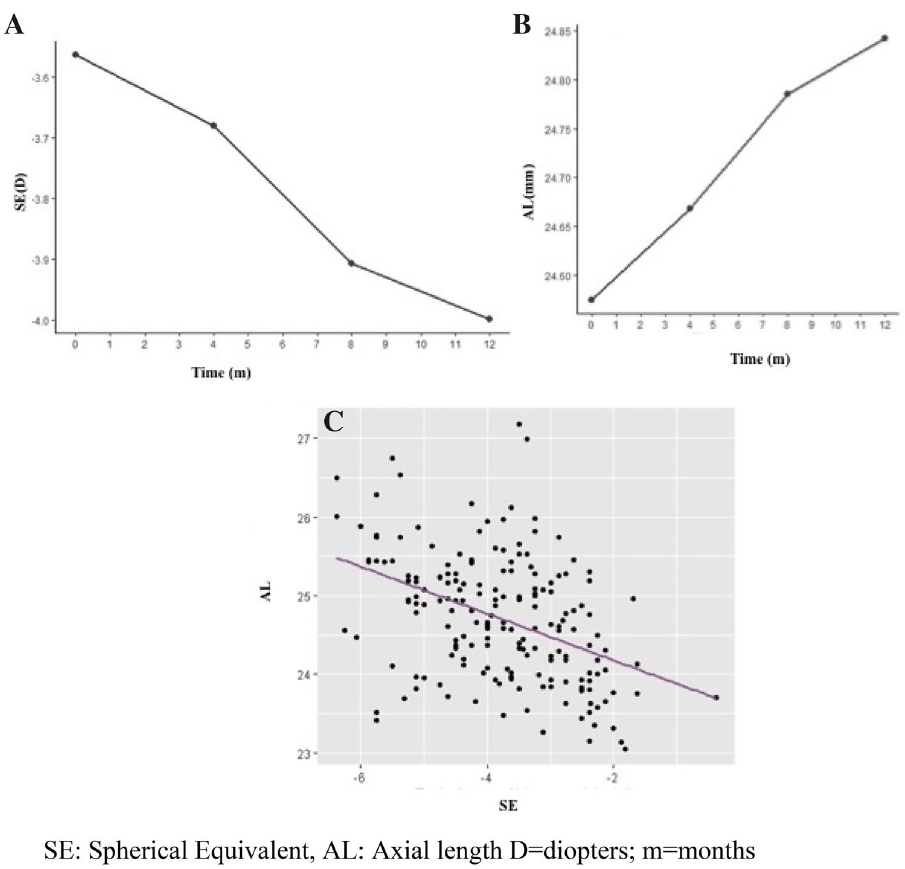
Figure 1. A Change in spherical equivalent across the time. B Change in axial length across the time. C Spherical equivalent and axial length progression correlation (Pearson Correlation r: − 0.42; p < 0.0001). SE Spherical Equivalent, AL Axial length D diopters, m months.